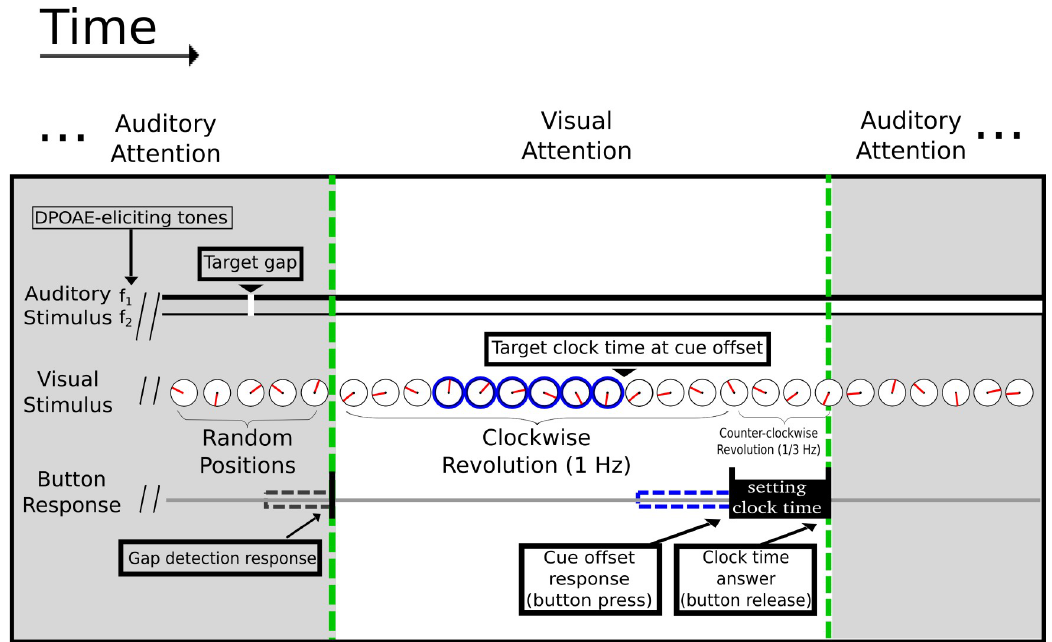
Fig 1. Illustration of the visual/auditory selective attention tasks. Subjects were required to alternate their attention between the visual and auditory modalities after each trial. The green dashed lines delimit the switch between auditory (grey shaded area) and visual (white area) attention. During visual attention a minute indicator (shown in red) rotates clock-wise at 1 Hz. After a random passive period of 2,000–2,500 ms, a peripheral clock rim appears as a temporal visual cue (shown in blue) and remains on for a variable period of 1,500–2,500 ms. Subjects were asked to report the position of the clock at the off-set of the peripheral clock rim. Simultaneously, in order to evoke DPOAEs, two tones (f1 and f2) were presented continuously, without silence gaps, during the visual attention task. On selective auditory attention trials (shaded grey), volunteers were required to report a brief (2–4 ms) silence gap embedded in the continuous DPOAE-eliciting tones. Gap detection triggered the switch to the random passive period of 2,000–2,500 ms before the initiation of the visual attention